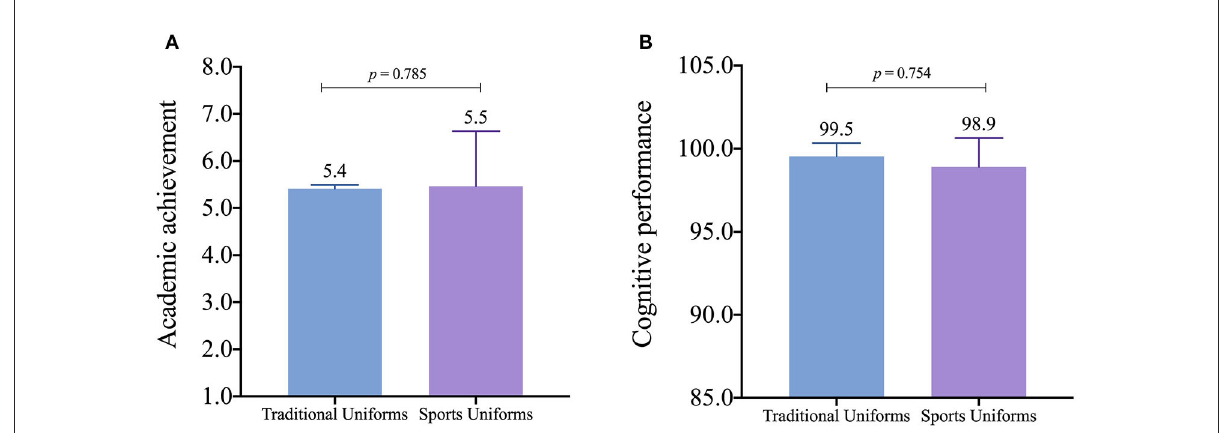
FIGURE1 Differences between academic achievement and cognitive performance in adolescents according to uniform types. Estimated marginal means and standard error. Figure according to model 2 (adjusted for sex, PHV, BMIz, physical fitness, and